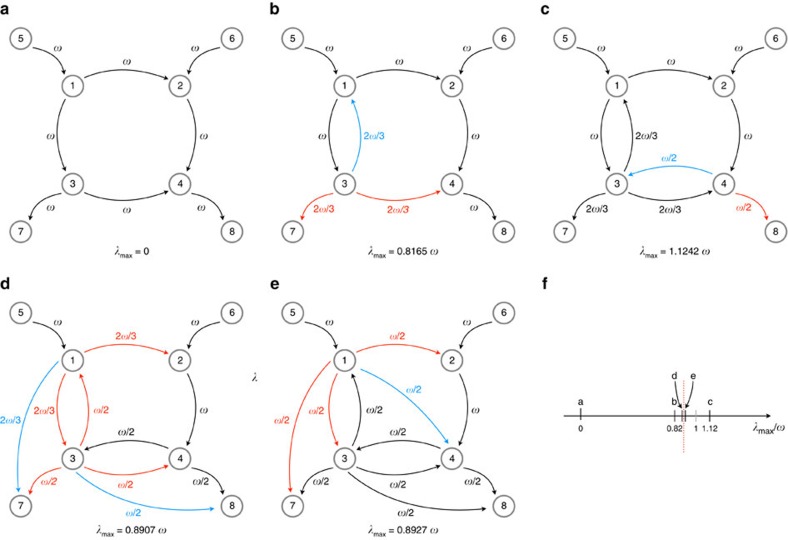
Toy model of an interbank network that oscillates between stability and instability.Going from a–e we add one or more edges every time, always redistributing the weights so that interbank leverages do not change. Added edges are green, while modified edges are red. The initial network in a is a DAG, hence λmax=0, and for simplicity all edges have the same weight ω. Suppose that, as we show in f, ω is chosen such that λmax<1 in d, but λmax>1 in e. We then have that network in b is stable, even though a cycle has appeared. The further addition of one more cycle makes network in c unstable. Network in d becomes stable again after the addition of two edges, and finally network in e is again unstable.